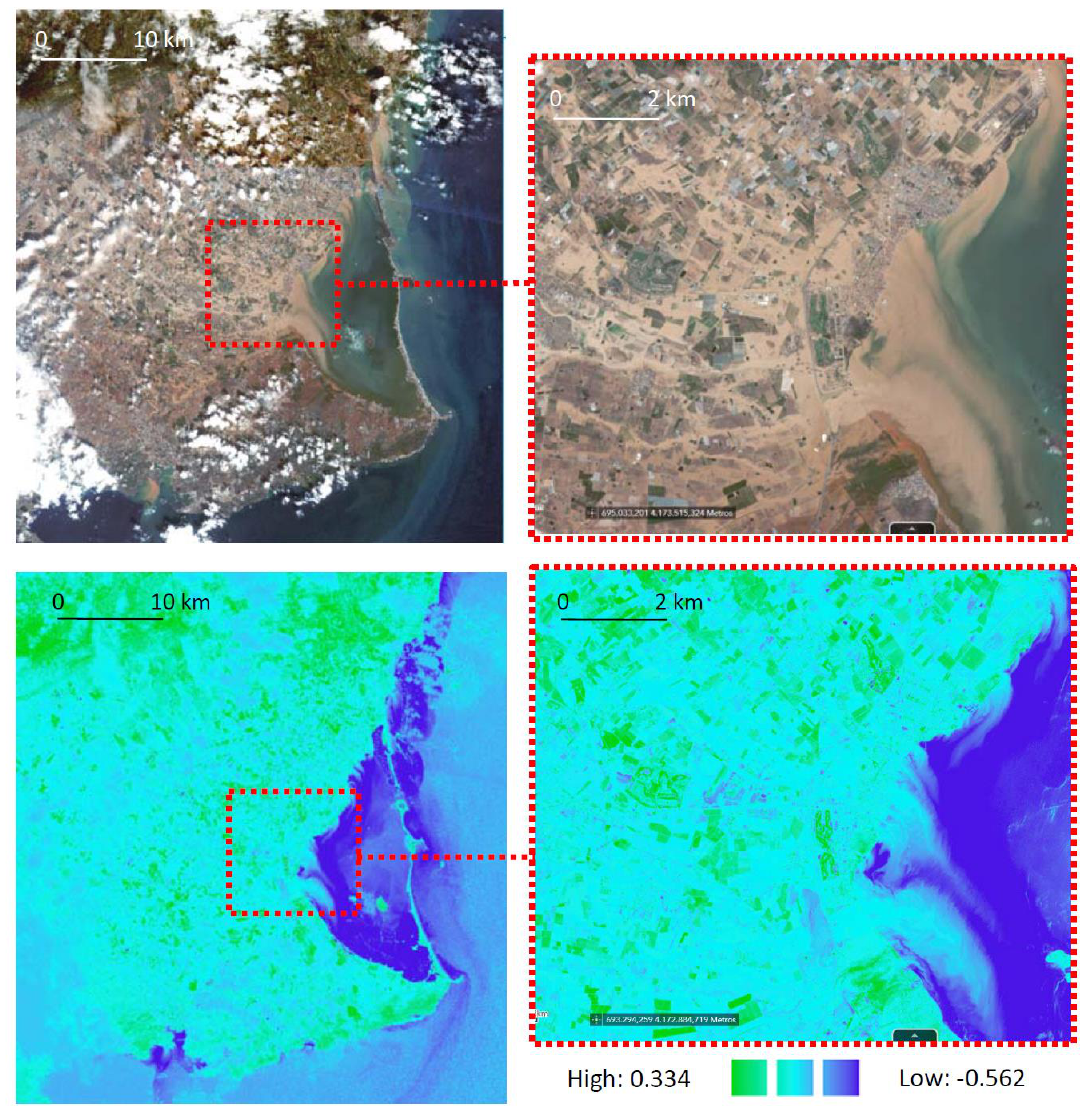
Figure 9. NDVI representation of flooding distribution in the study area associated to the DANA episode of 2019. Source of data: Sentinel 2 satellite (consulted for 13/09/2019).